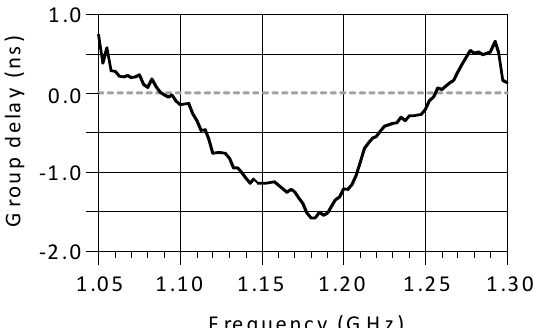
Figure 12: Group delay )( f τ of the designed NGD circuit tested.